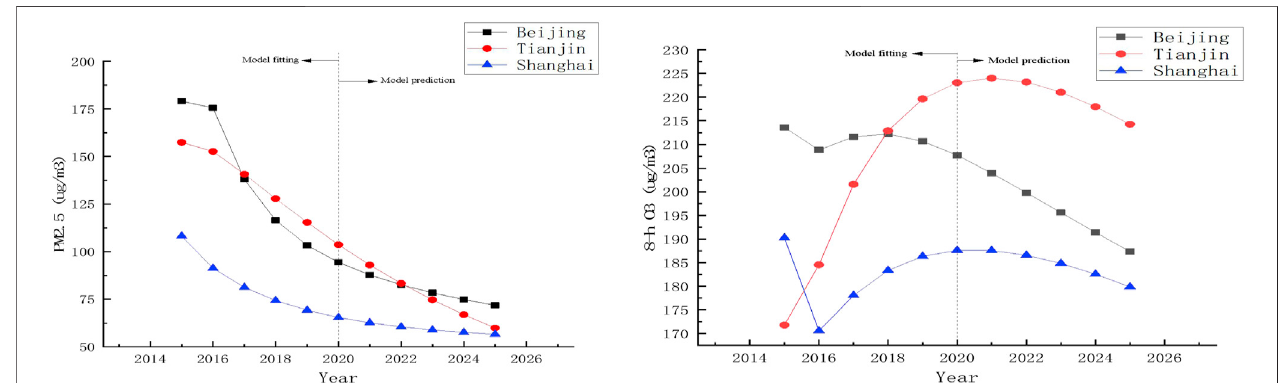
FIGURE 2 | Trends of annual average concentrations of PM 2.5 and 8-h O 3 in three cities.